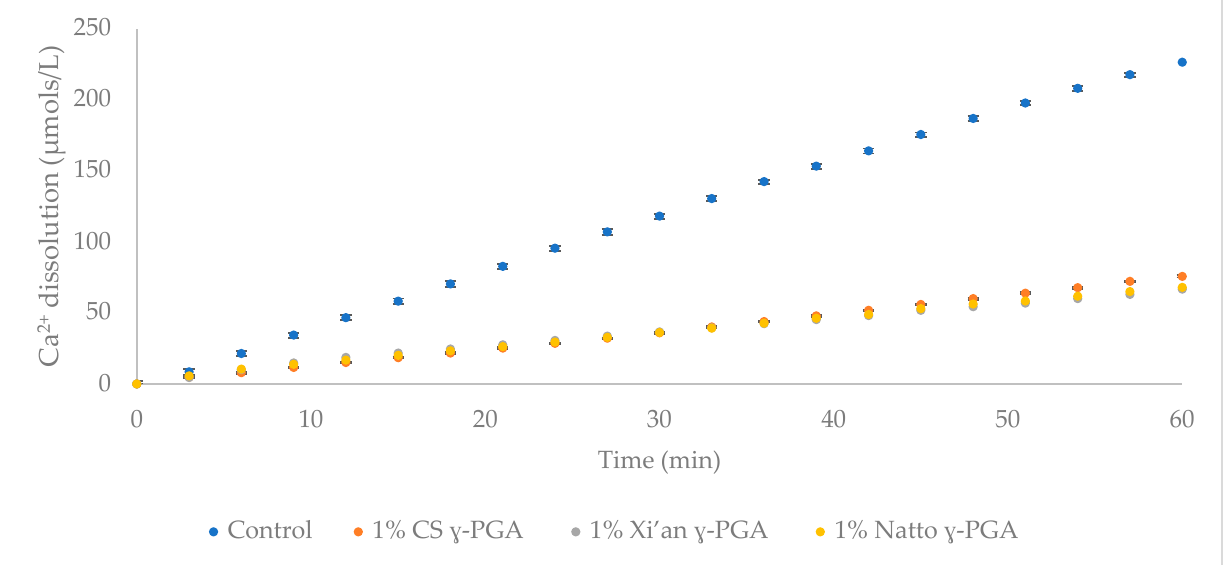
Figure 5. Linear regression analysis of the ISE pilot study result showing the Ca 2+ activity from HAp disc (20% porous) protected by different commercial γ -PGA at 1% (w/v) with disc immersion for 2 min. n = 3. Error bars indicate standard error values.